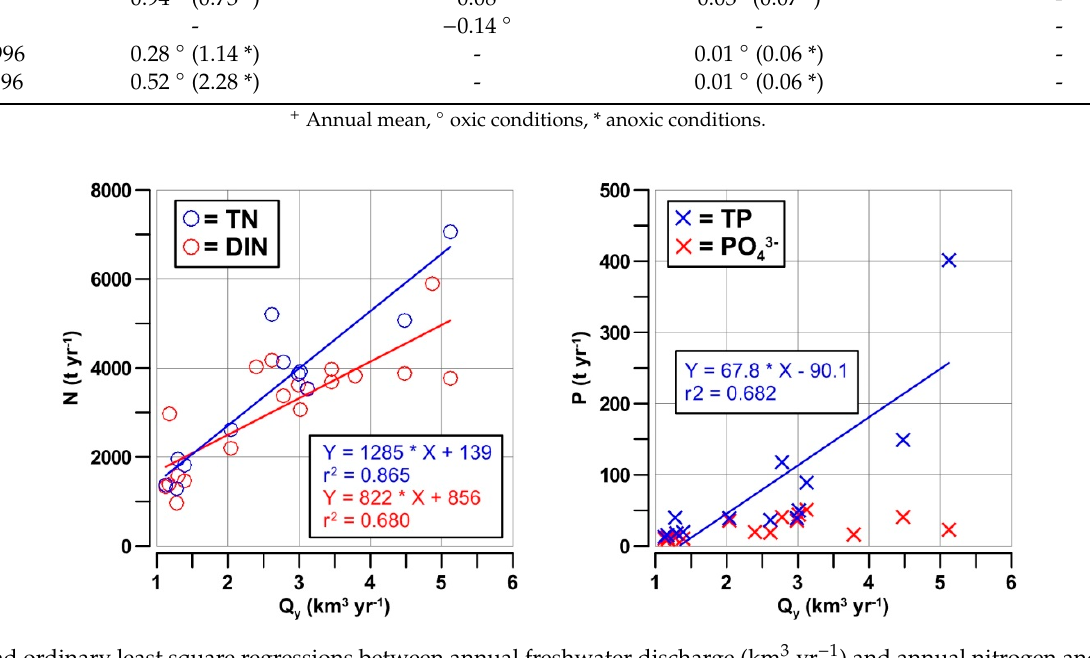
Figure A2. Relationships and ordinary least square regressions between annual freshwater discharge (km 3 yr − 1 ) and annual nitrogen and phosphorus discharges (tons yr − 1 ) of the Isonzo River in 2016.